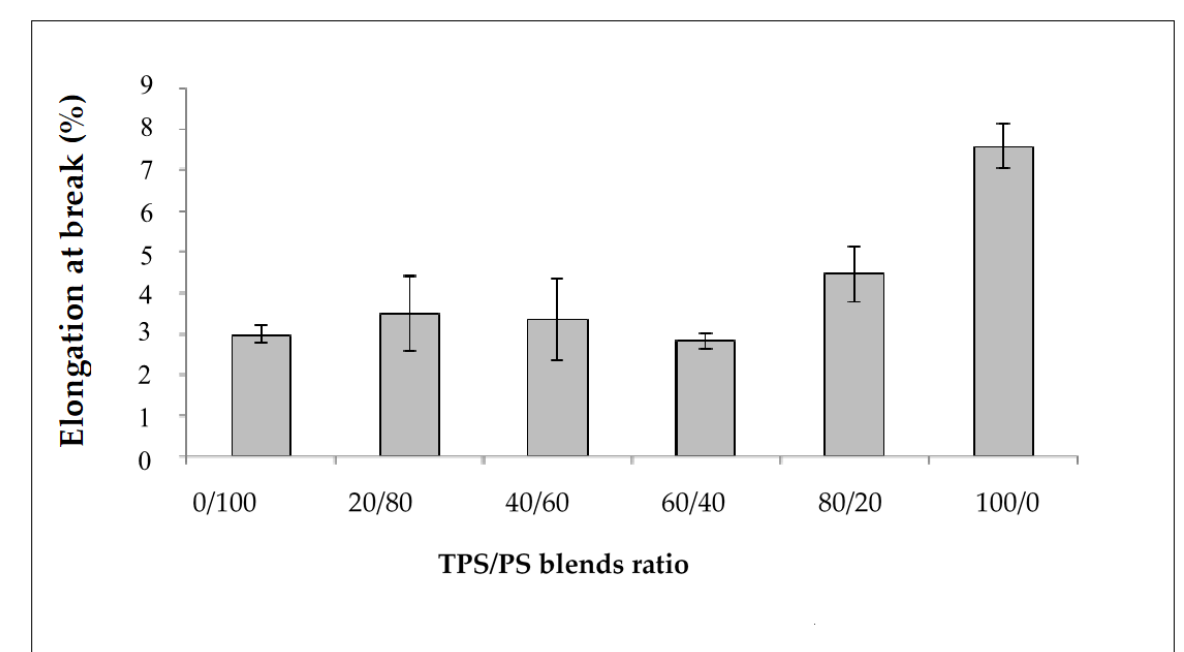
Figure 3. Elongation at break of TPS/PS blends at different ratios .